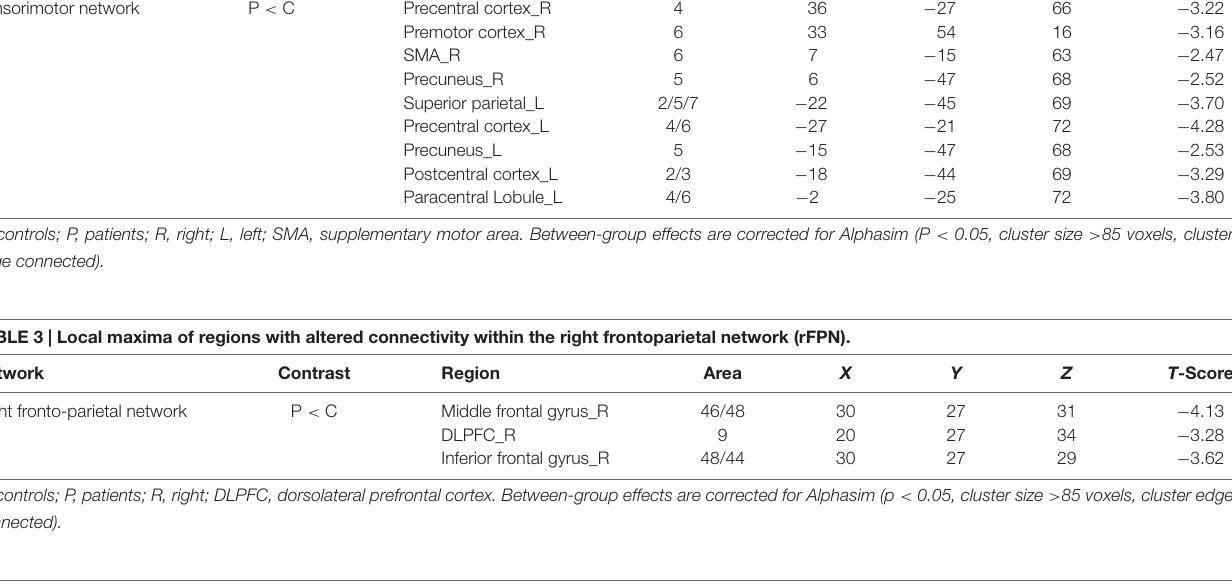
TABLE 4 | Local maxima of regions with altered connectivity within the salience network (SN). Network Contrast Region Salience network P > C